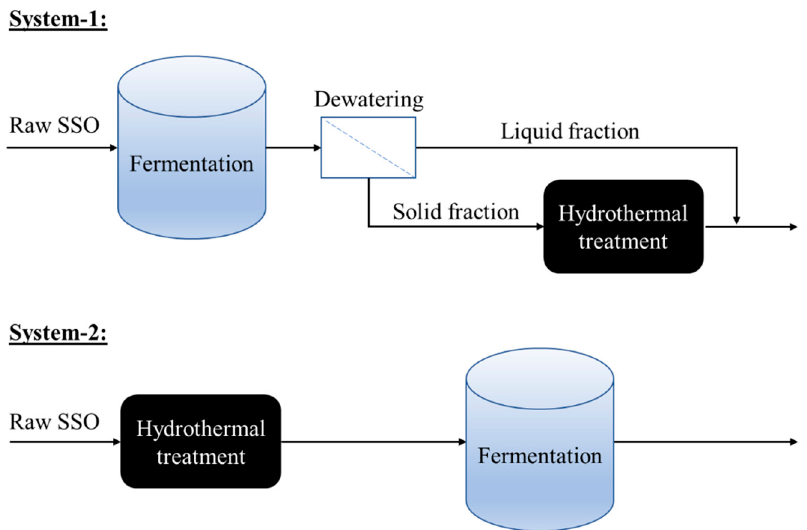
Figure 5. Schematic diagram showing the experimental set-up.